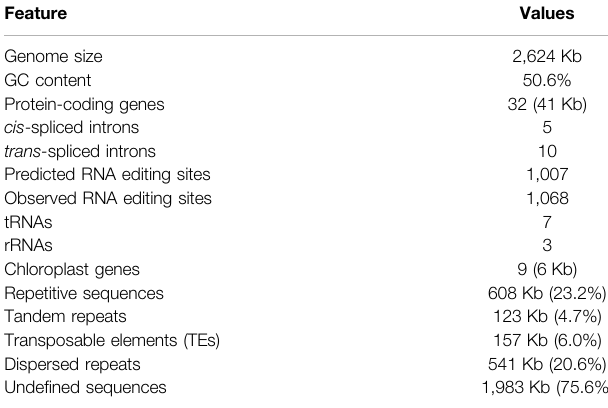
TABLE 2 | Characteristics of the Platycladus orientalis